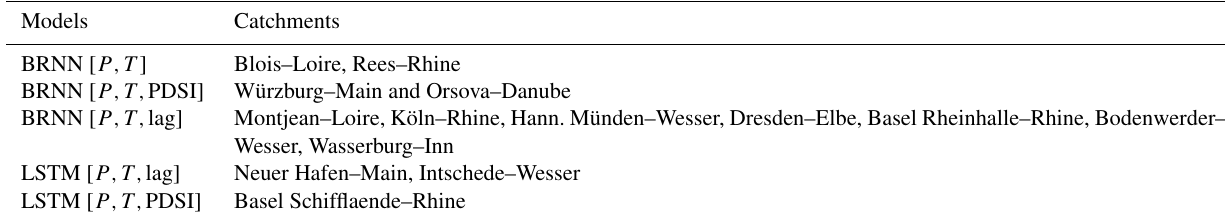
Table 3. Selection of best model for runoff in individual catchments.